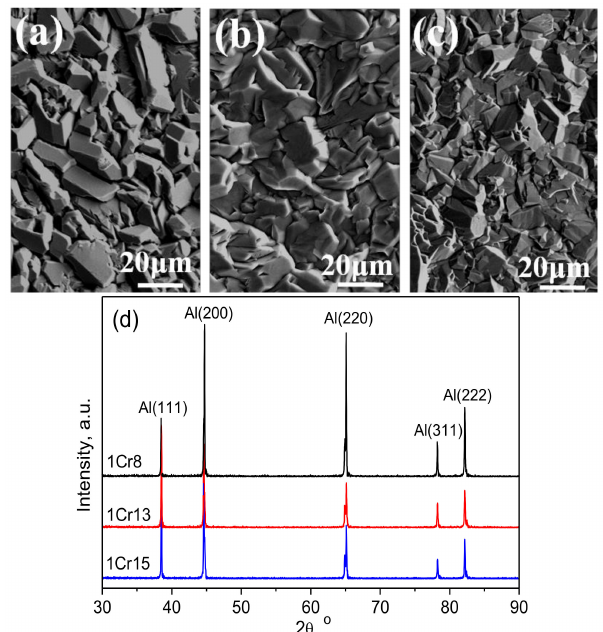
Figure 2. Surface topographies of Al coatings formed on ( a ) 1Cr8, ( b ) 1Cr13, and ( c ) 1Cr15 steel substrates and ( d ) the corresponding XRD patterns after 1 h of ionic liquid (IL) plating.